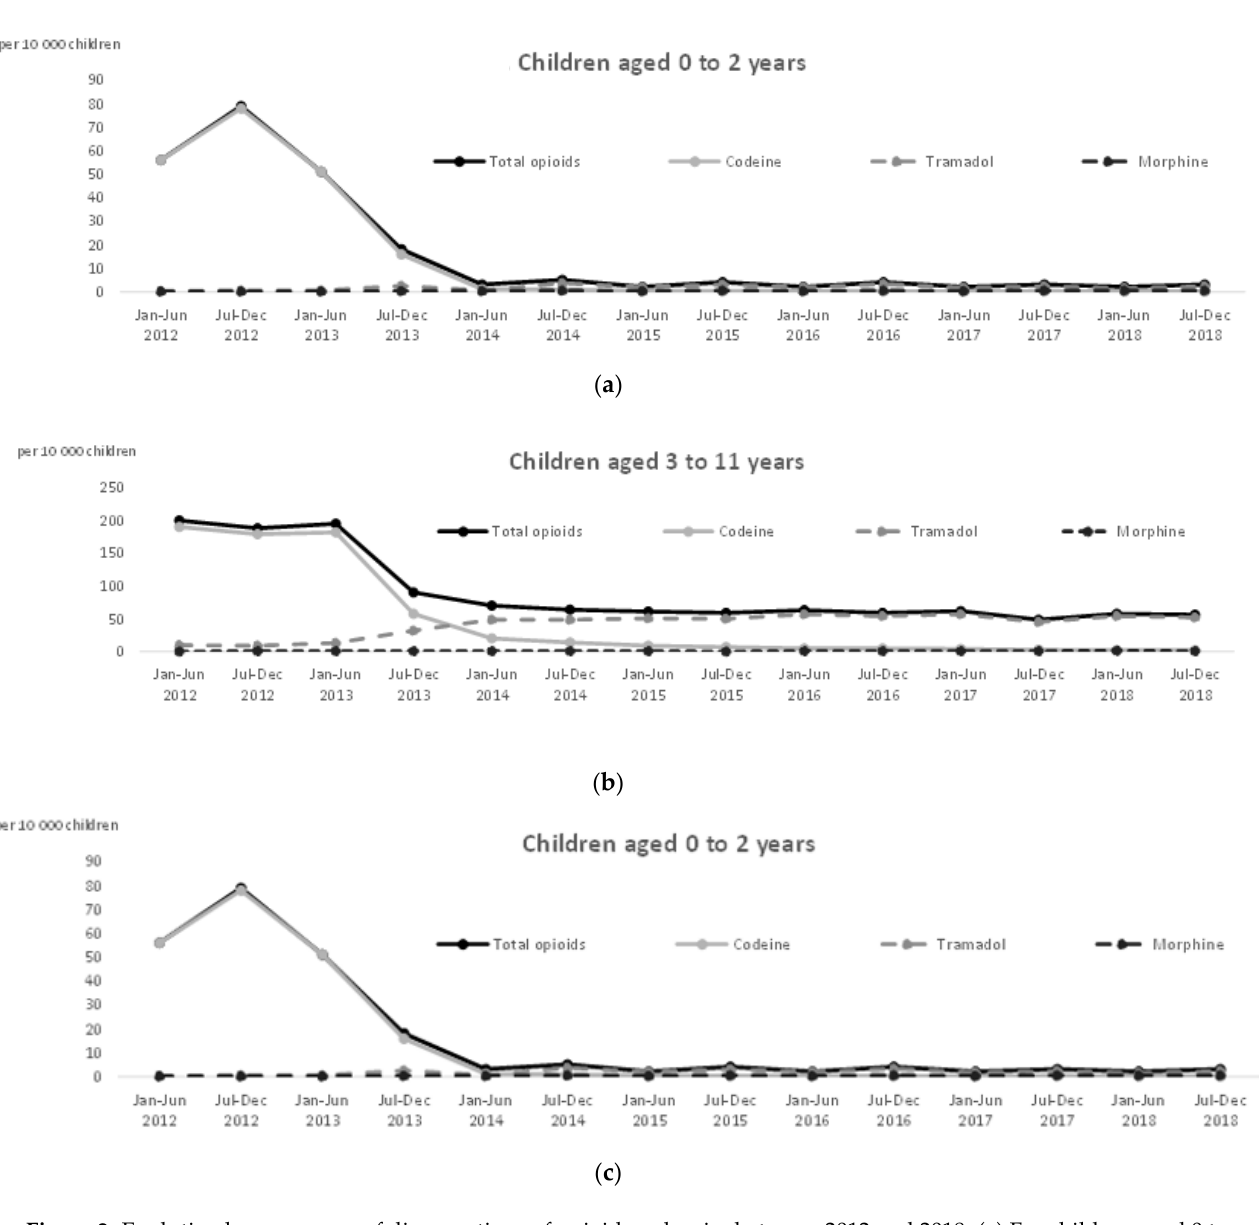
Figure 2. Evolution by age group of dispensations of opioid analgesics between 2012 and 2018. ( a ) For children aged 0 to 2 years; ( b ) for children aged 3 to 11 years; ( c ) for children aged 12 to 15